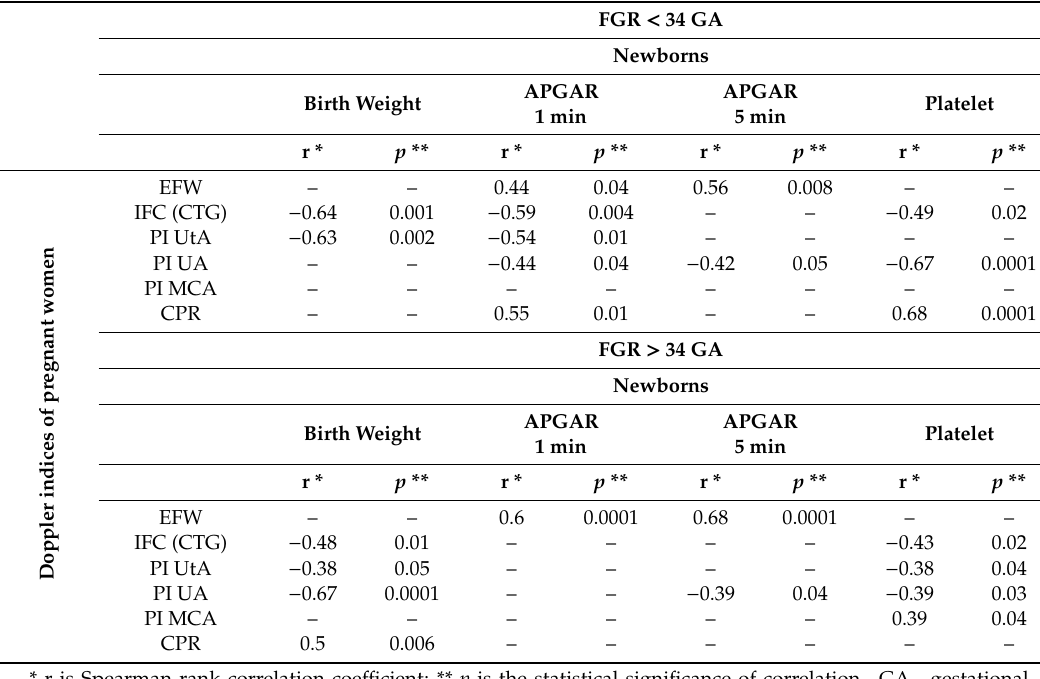
Table 5. Results of correlation of Doppler measurement of pregnant women and clinical state assessments of newborns with